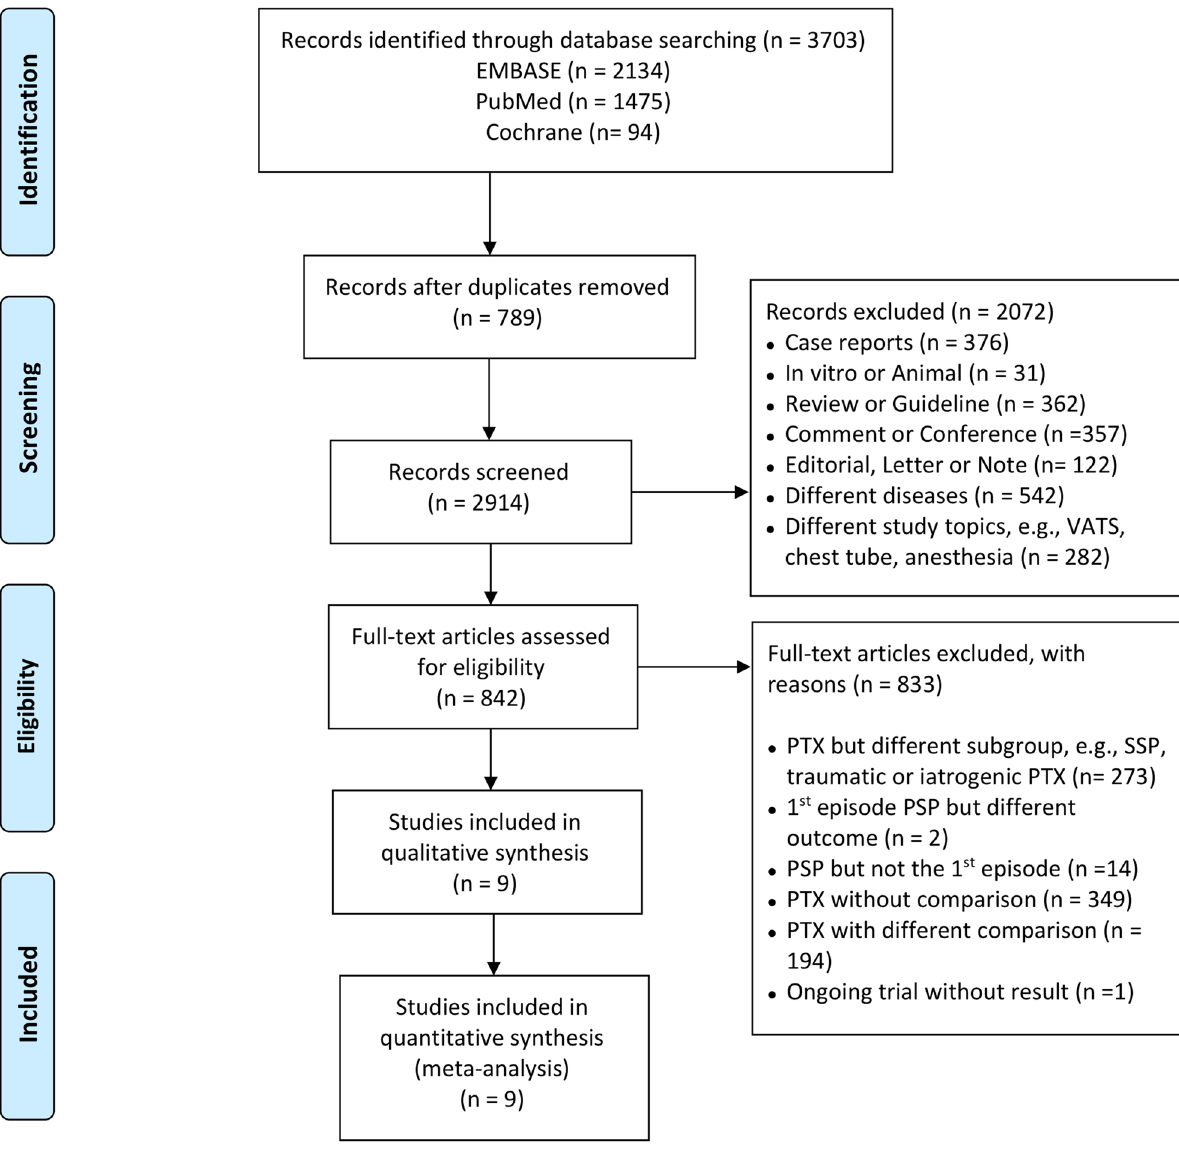
Figure 1. Flow chart of clinical trial selection. The study protocol was conducted in accordance with the Preferred Reporting Items for Systematic Reviews and Meta-Analyses (PRISMA) statement (Moher et al.